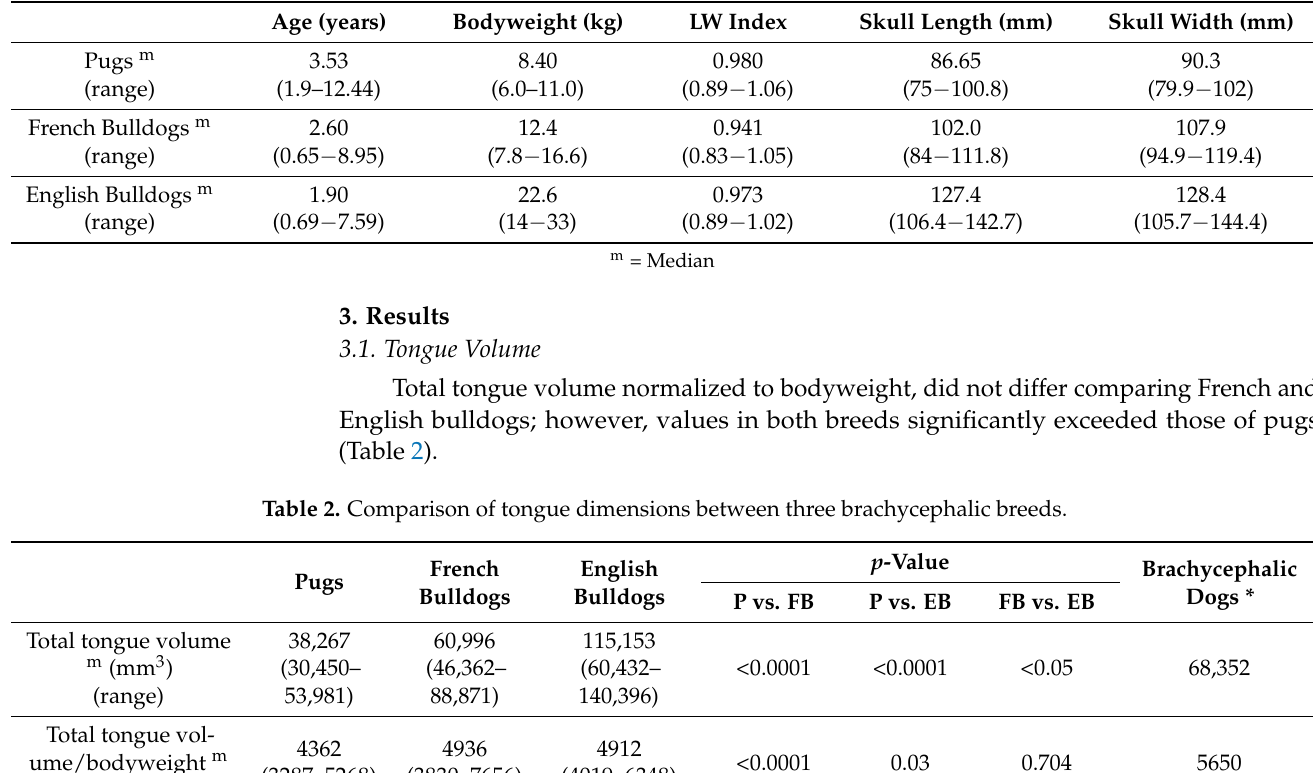
Table 1. Comparison of age, bodyweight, and skull conformation between three brachycephalic breeds.